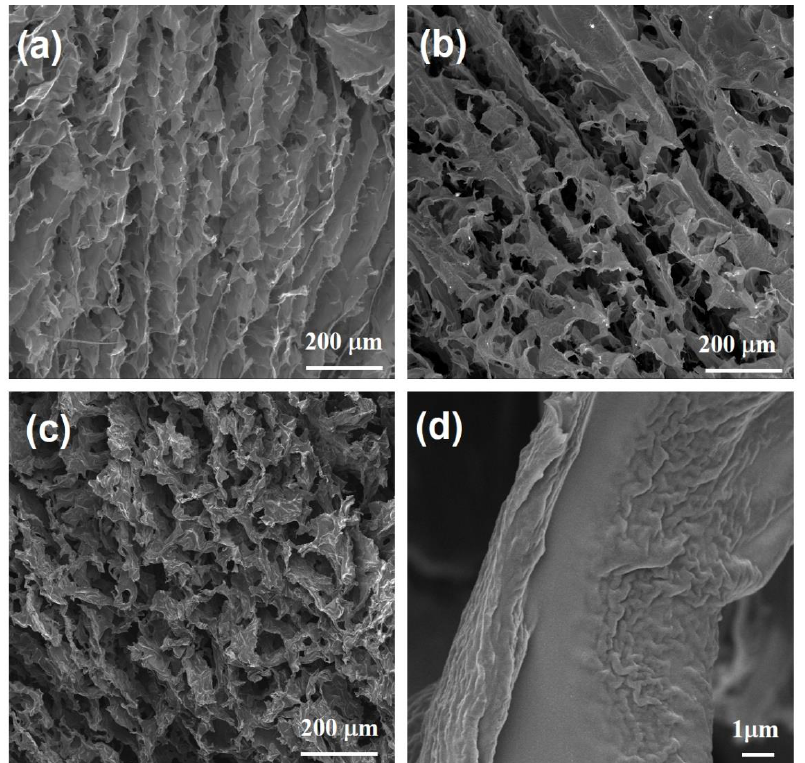
Figure 2. Low-magnification SEM images of ( a ) RGOA, ( b ) RGOA-1000, and ( c ) RGOA-1000/SiOC samples. ( d ) High-magnification SEM image of RGOA-1000/SiOC sample.